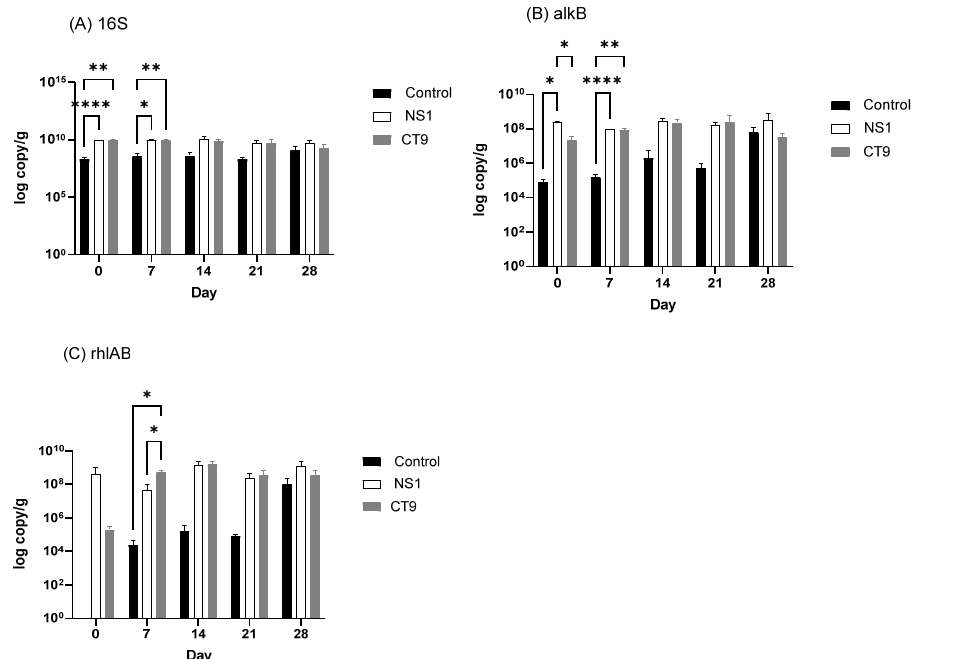
Figure 7. Gene abundance of ( A ) 16S rRNA, ( B ) alk B, and ( C ) rhl AB quantified by real-time PCR in the NS1, CT9, and control soils during the 28-day incubation. Note: the numbers are mean values of triplicates. One-way ANOVA conducted the statistical test. “****” indicates p < 0.0001, “**” indicates p < 0.01, and “*” indicates p <